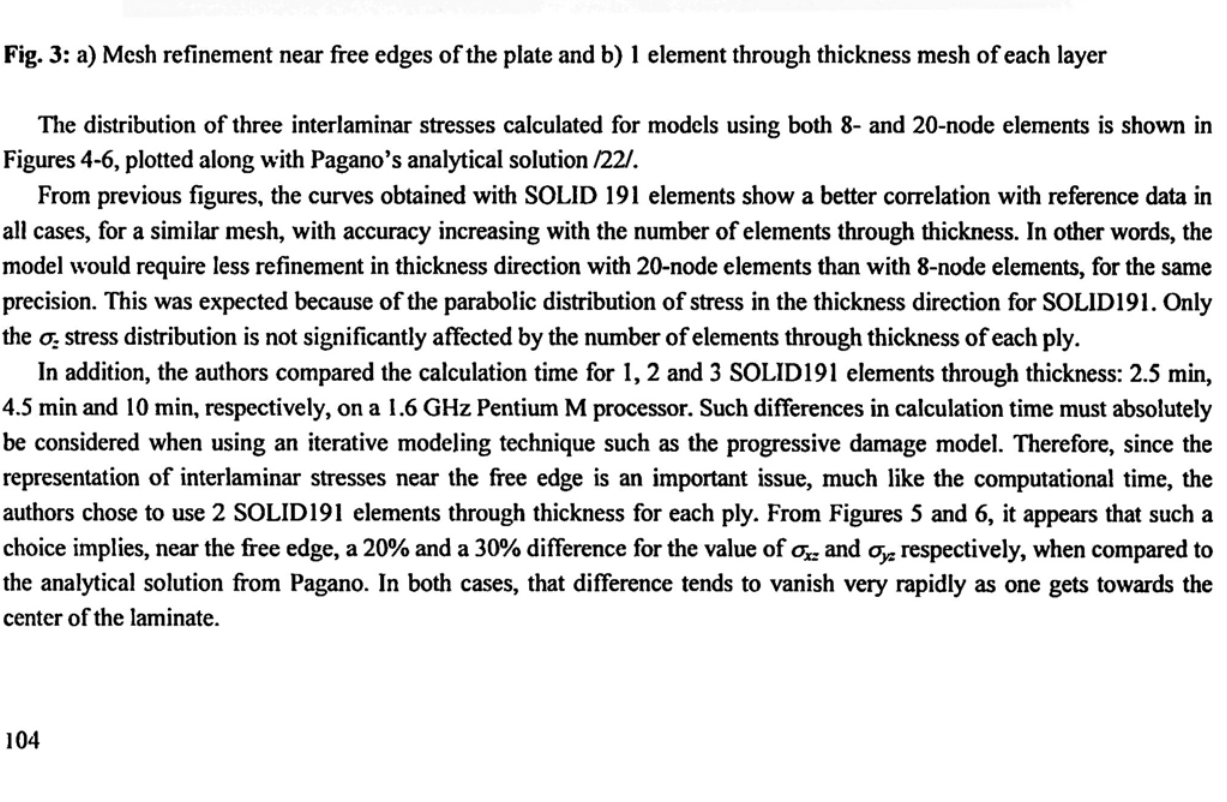
Fig. 2: Laminate under uniaxial